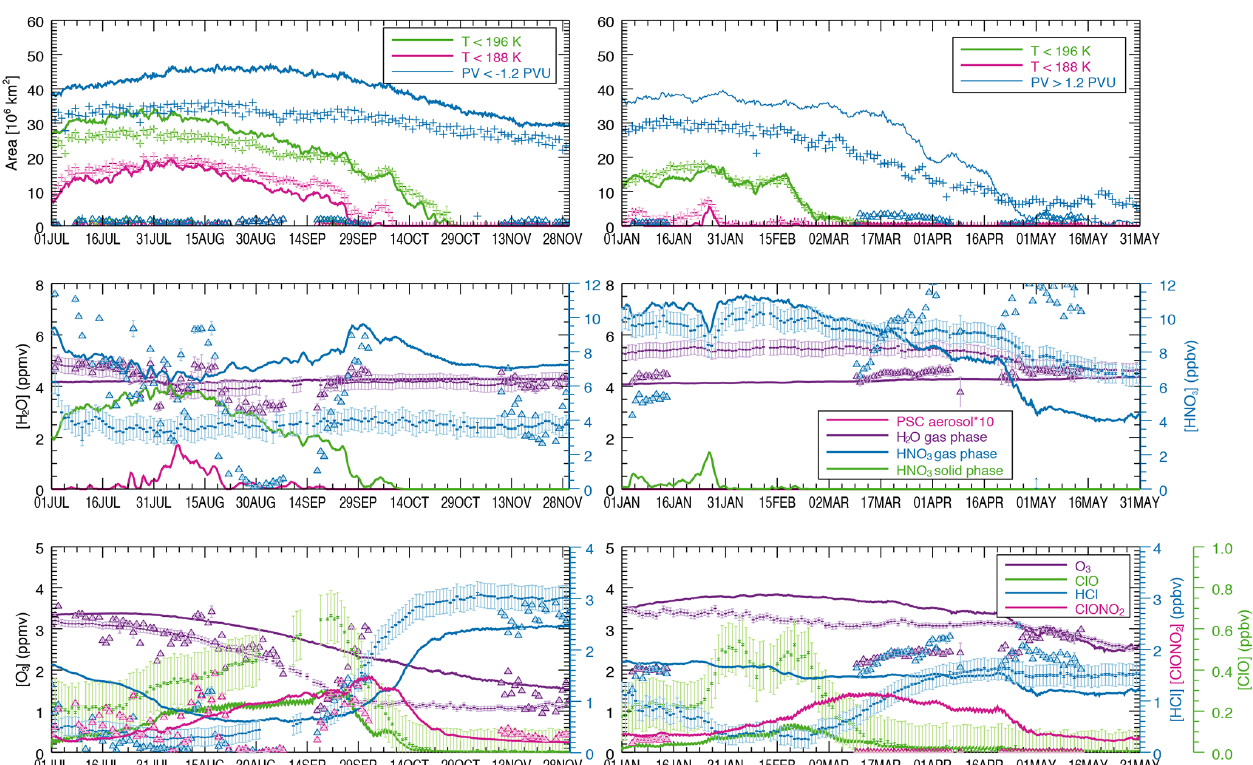
Figure 13. Polar vortex diagnostics for SH winter 2006 (left column) and NH winter 2005 (right column) on the 500K isentropic surface. Top panels show the area of polar vortex defined as sPV > 1 . 2 × 10 − 4 s − 1 (blue) for the NH and sPV < − 1 . 2 × 10 − 4 s − 1 for the SH, area where temperature is below 196K (green) and below 188K (pink). The middle panels show polar vortex averaged H 2 O (purple), HNO 3 (blue), solid H 2 O or PSC aerosol (pink) and solid HNO 3 (green). Bottom panels show polar-vortex-averaged ozone (purple), HCl (blue), ClO (green, Aura-MLS and CMAM30 only) and ClONO 2 (pink, ACE-FTS and CMAM30 only). CMAM30 is shown as solid lines, ACE- FTS as triangles with error bars (cumulative errors), and Aura-MLS as dots with error bars (root mean square errors in dark colours and cumulative errors in corresponding lighter colours). Solid water vapour (PSC aerosol, CMAM30 only) amounts are scaled by a factor of 10. Note that HNO 3 and ClO amounts for the middle and bottom panels, respectively, are denoted on the rightmost axes for both left and right